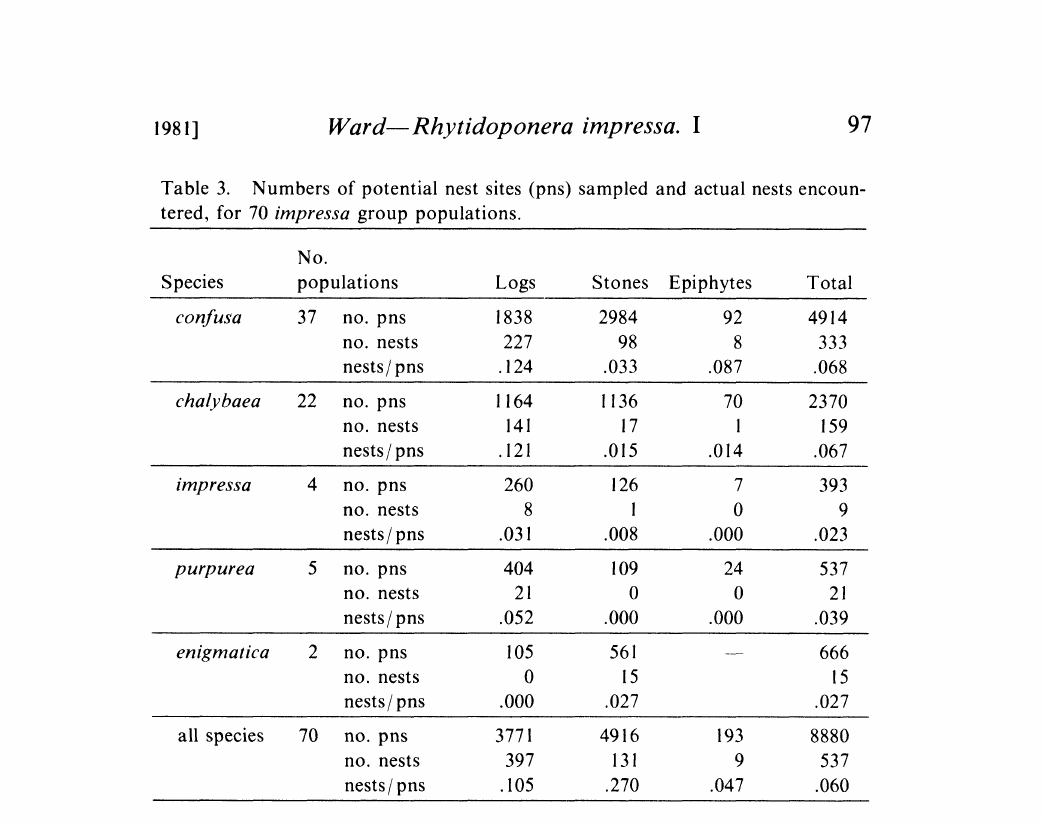
Table 3. Numbers of potential nest sites (pns) sampled and actual nests encoun- tered, for 70 impressa group